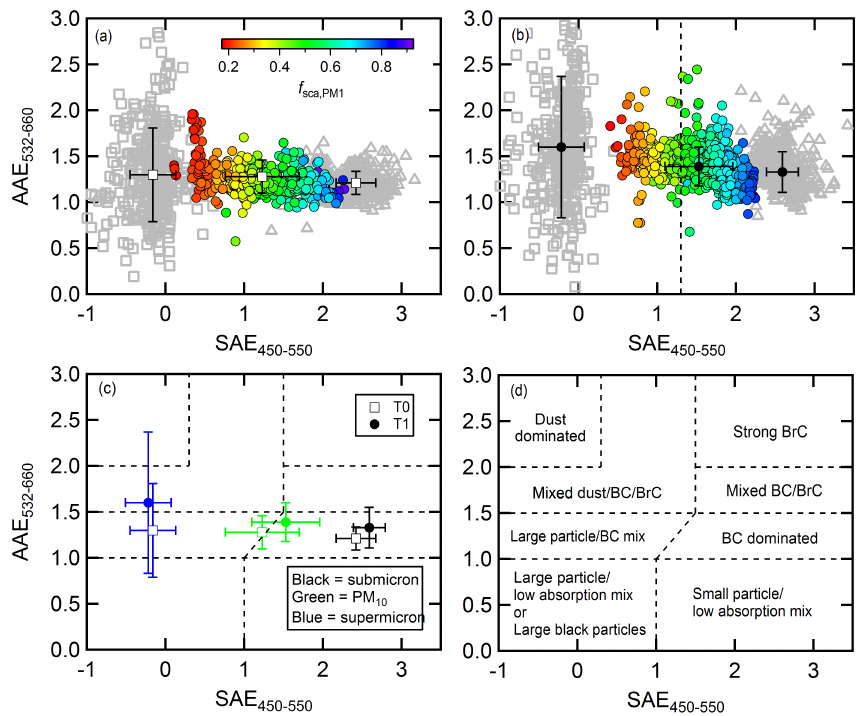
Figure 8. Observed relationship between the AAE (532–600nm pair) and the SAE (450–550nm pair) for PM 10 (colored circles), submicron (open gray triangles) and supermicron (open gray squares) particles for the (a) T0 and (b) T1 sites. (c) Comparison between the PM 10 (green), submicron (black) and supermicron (blue) particle averages between the T0 (filled circles) and T1 (open squares) sites. (d) An alternate classification scheme to that suggested by Cazorla et al.